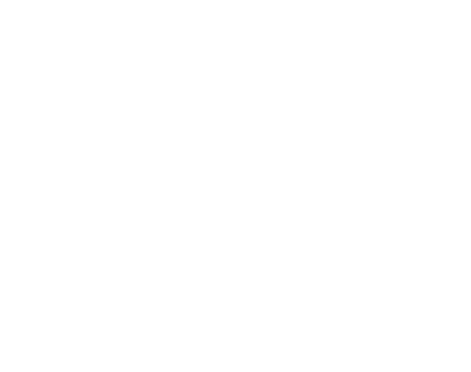
Figure 15. Reconstructed cross-sectional image of Phantom